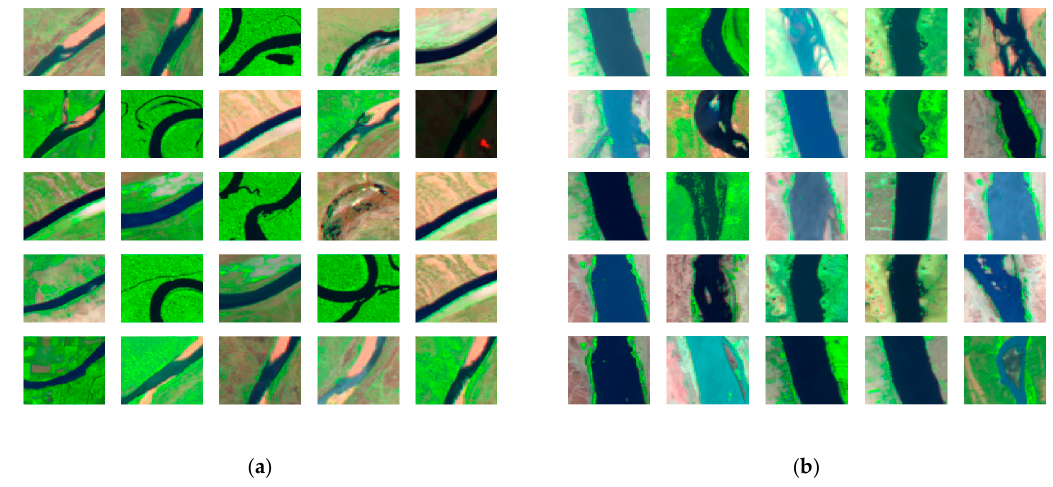
Figure 5. Example of different categories of river type from the dataset: ( a ) River type category 1, ( b ) River type category 2.